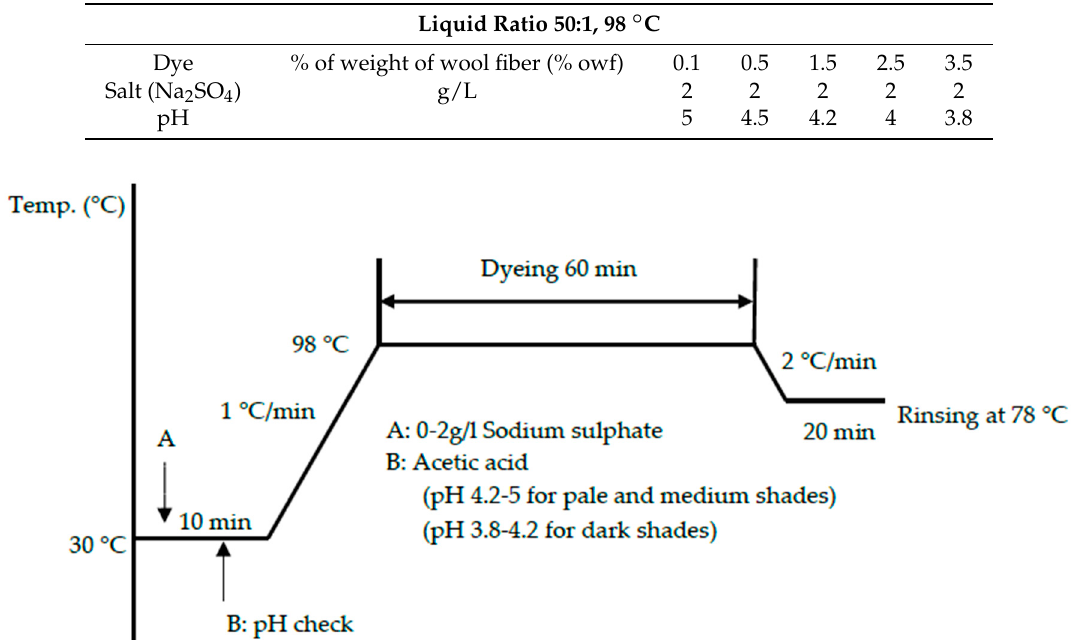
Table 2. The concentration of Na 2 SO 4 and pH at various weight percentages of reactive dye for conventional water dyeing.